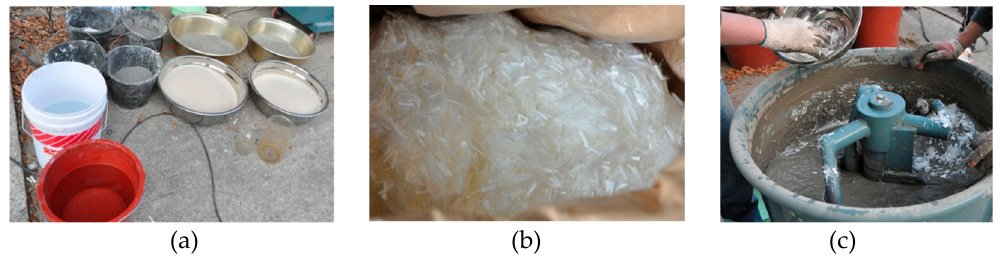
Figure 1 . Mixing and manufacturing of SHCC, ( a ) mixing materials, ( b ) PVA fibers, ( c ) mixing of SHCC. For the compressive test on hardened SHCC, three specimens of SHCC from cubic molds were manufactured and the compressive strength of SHCC at 28 days was measured as an average of 39.2 MPa. To evaluate the tensile characteristic of hardened SHCC, on the other hand, a direct uniaxial tensile test was carried out using a 10 kN capacity universal testing machine (UTM) by controlling the displacement of 0.2 m/min, as shown in Figure 2.